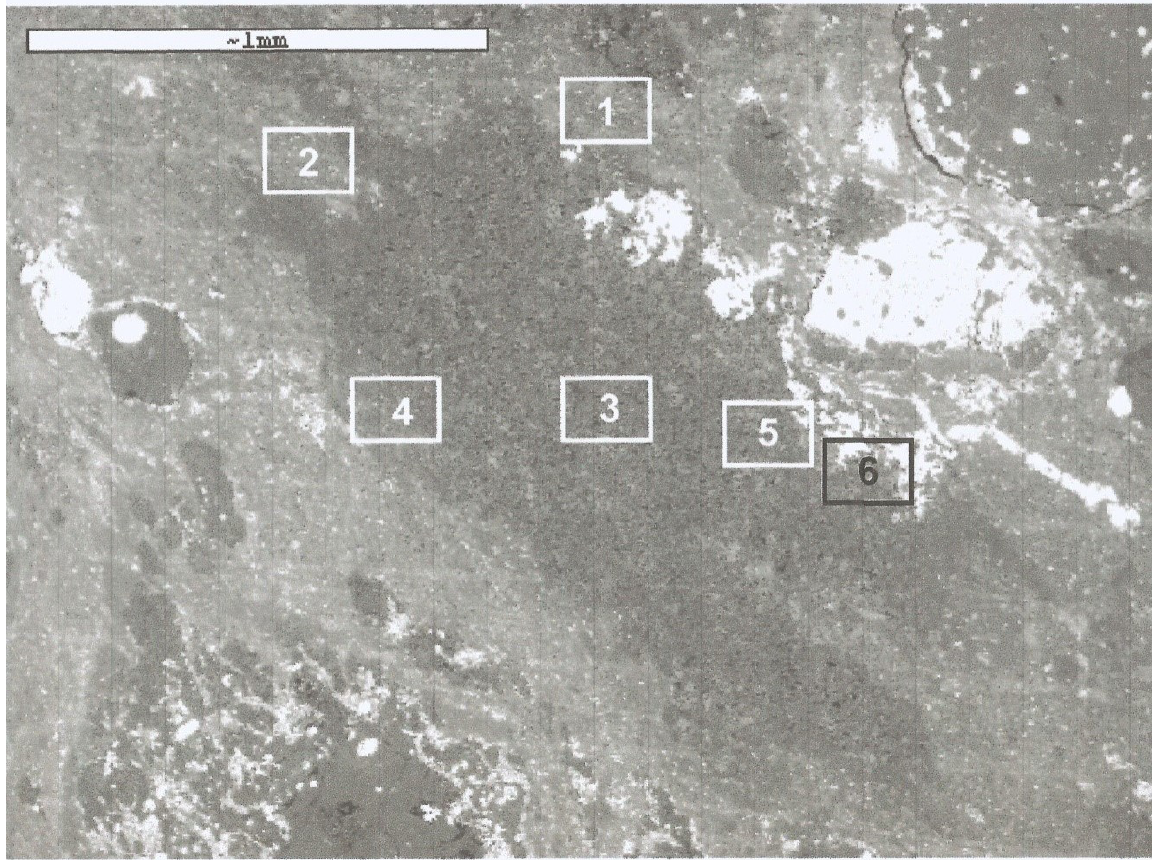
Figure 3. Backscattered Electron Imaging of a selected area of aCalcium-Aluminium inclusion from the Kaba meteorite showing the analyz- ing points for the cathodoluminescence spectral